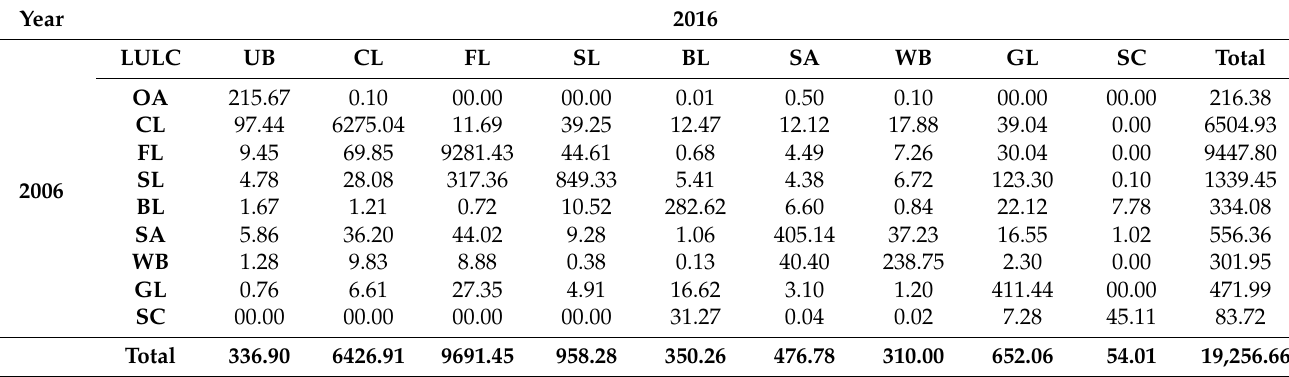
Table 6. LC transition from 2006 to 2016.